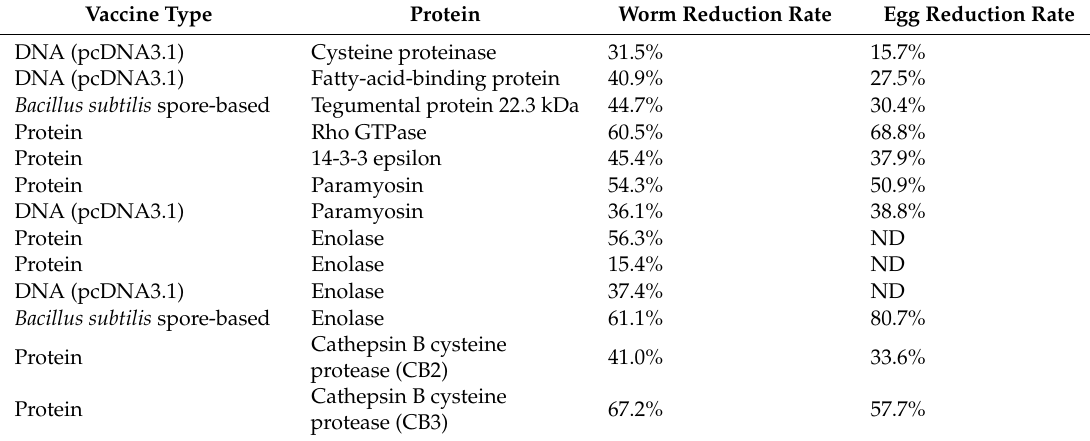
Table 2. Vaccine candidates tested against Clonorchis sinensis in the rat model of infection (Modified from [53]). Vaccine Type Protein Worm Reduction Rate Egg Reduction Rate